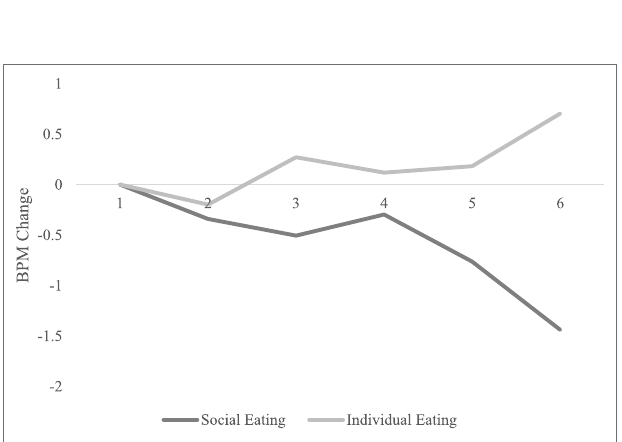
FIGURE 4 | Heart rate in beats per minute as a function of time of exposure and type of social eating cues present in the obesity PSA messages.